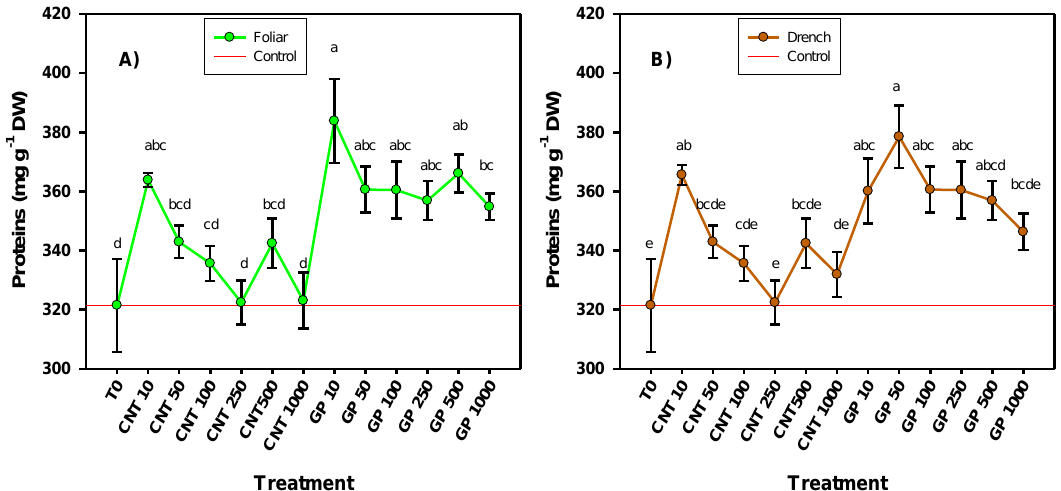
Figure 5. Protein content in tomato seedlings treated with an application of carbon nanomaterials applied via foliar ( A ) and drench ( B ). T0: control; CNTs: carbon nanotubes; GP: graphene; DW: dry weight; 10, 50, 100, 250, and 500 represent the mg L − 1 applied of each carbon nanomaterial. Different letters indicate significant differences among treatments according to Duncan ( α = 0.05). n = 5 ± standard error.